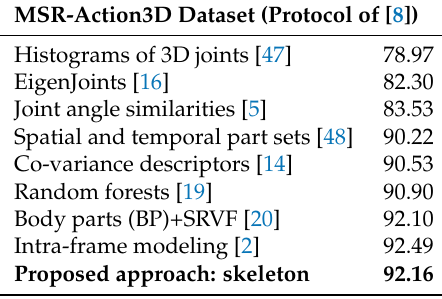
Table 2. Comparison with the state-of-the-art